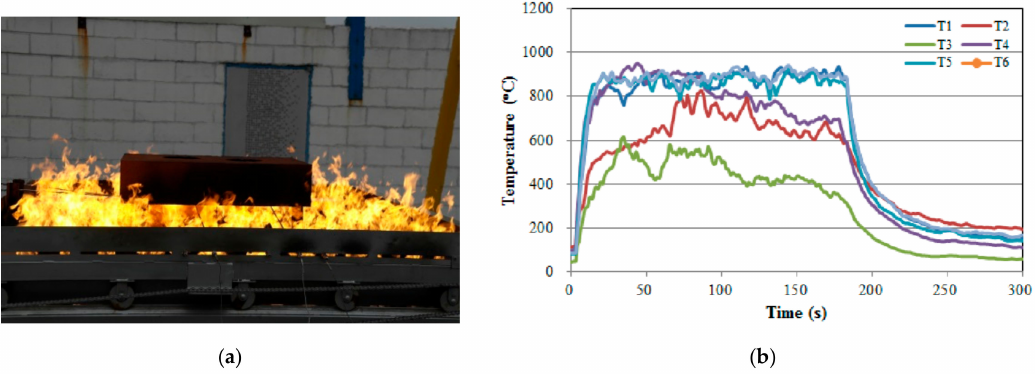
Figure 6. Experimental results of prototype test apparatus: ( a ) mock-up installed at the burner zone; ( b ) temperature profiles at six measurement